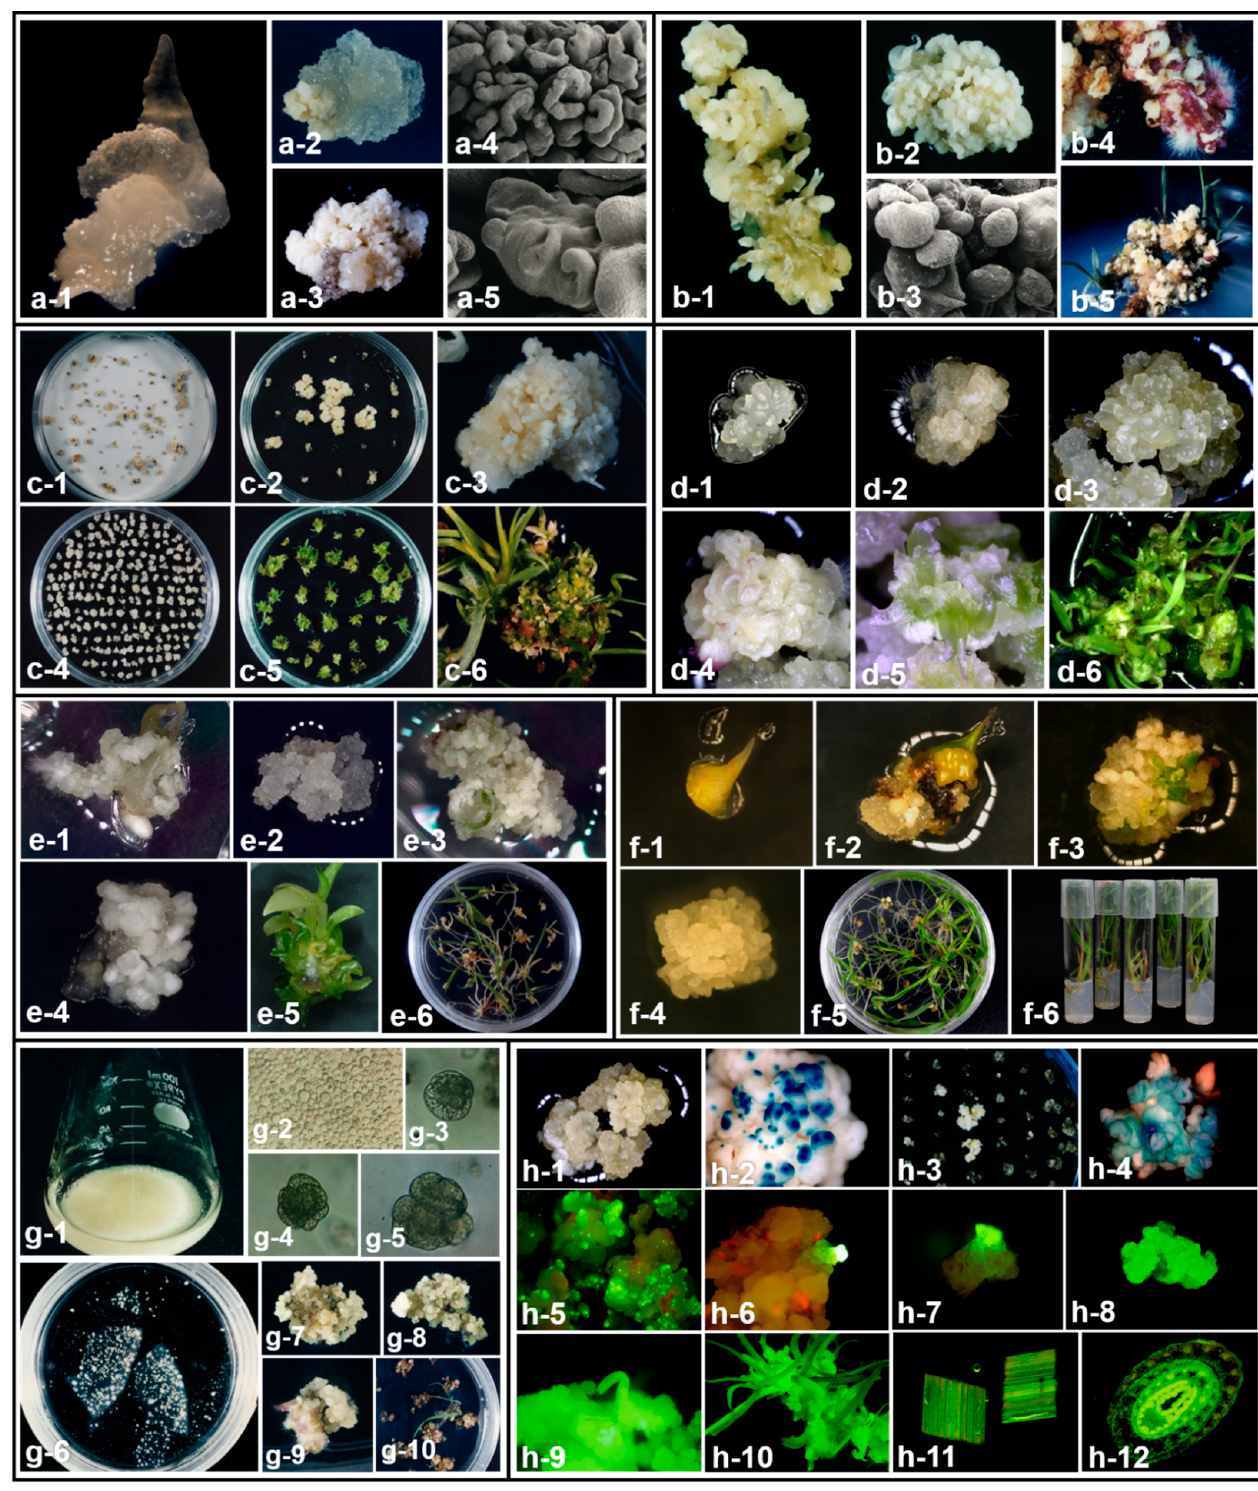
Figure 1. Somatic embryogenesis and its application to protoplast culture and genetic transformation in some warm-season grasses. ( a ) Somatic embryogenesis from immature zygotic embryos in Guinea grass ( Panicum maximum ). (1) Immature zygotic embryo, (2) non-embryogenic callus, (3) embryogenic callus, (4,5) SEM of somatic embryos at different stages of development. ( b ) Somatic embryogenesis from immature inflorescences and plant regeneration in dallisgrass ( Paspalum dilatatum ). (1) Primary callus after 14 d of culture, (2) embryogenic callus, (3) SEM of pro-embryogenic structures, (4,5)